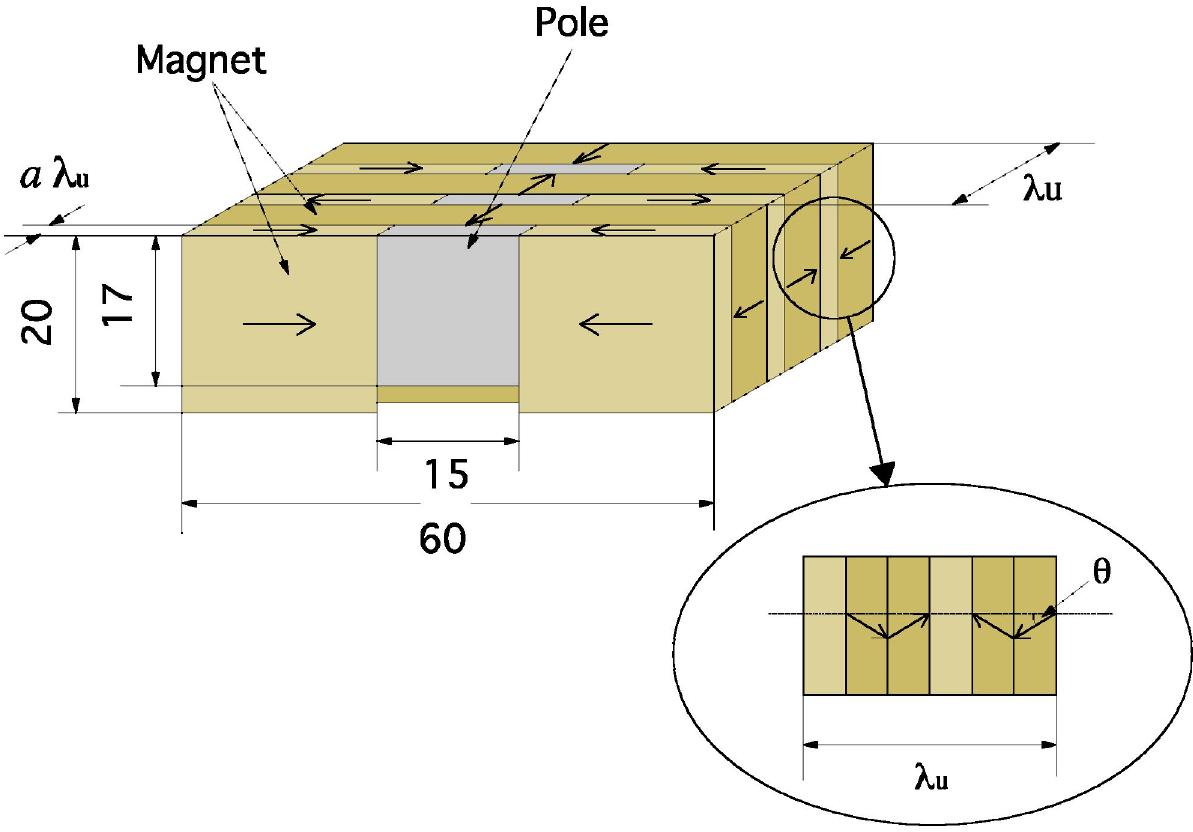
FIG. 4. (Color) Dimensions (mm) of hybrid CPMU used for calculations. a (cid:2) (cid:10) is a thickness of poles, where a is 0.178 for the u is an undulator periodic length. Permendur and dysprosium are used as pole 50BH undulator and 0.15 for the 53CR undulator. (cid:10) u materials for the 50BH and 53CR undulators, respectively. The case of tilted magnetization by an angle (cid:22) is shown in the